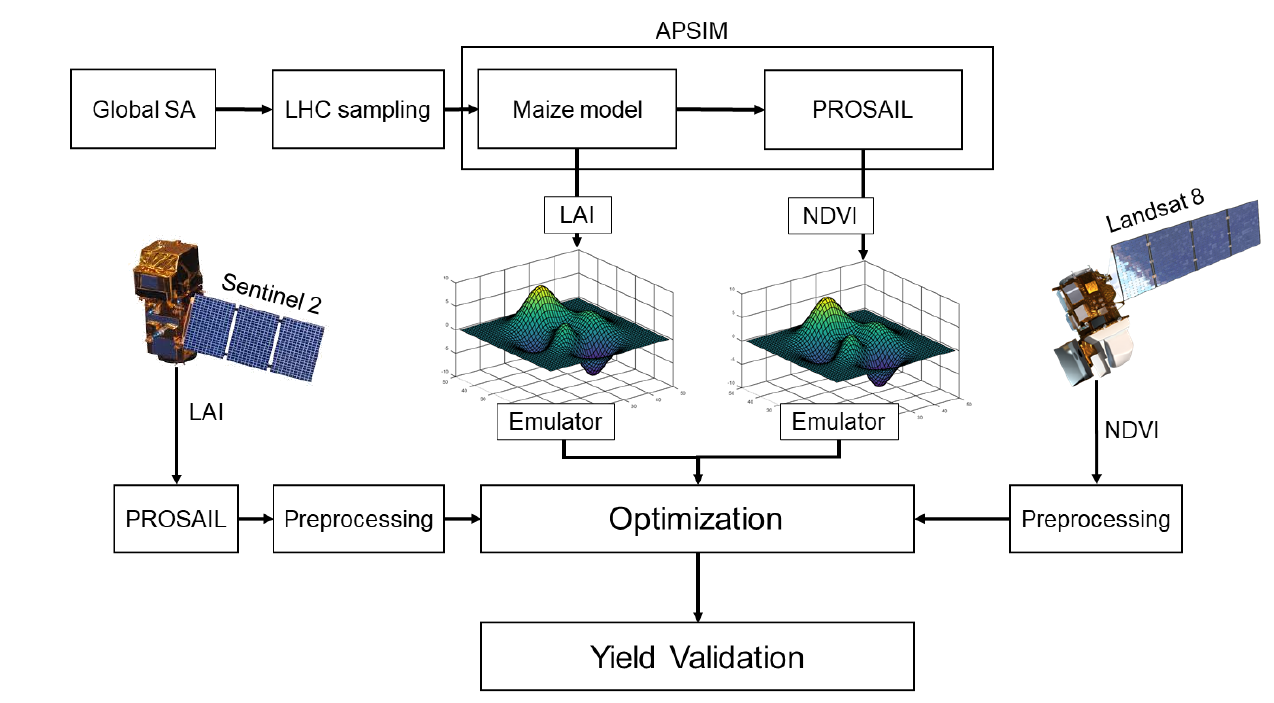
Figure 1. The overall workflow of linking APSIM-Maize model with radiative transfer model (PROSAIL) for developing the emulators, optimization procedure and model